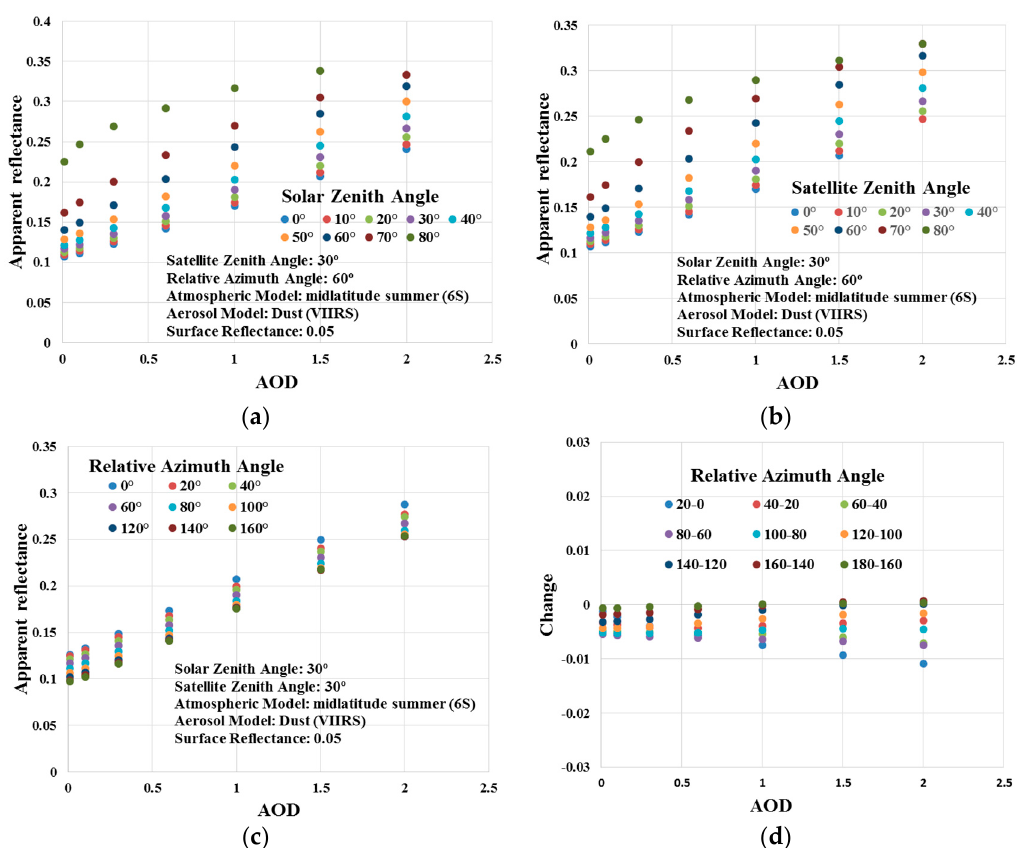
Figure 3. The change of simulated apparent reflectance in GF-1/WFV blue band with solar zenith angle ( a ), satellite zenith angle ( b ), relative azimuth angle ( c ) for different AODs. The change of apparent reflectance with different relative azimuth angle ( d ). In the simulation, the view geometry, atmospheric model, and aerosol model are set as shown in figure by 6S.